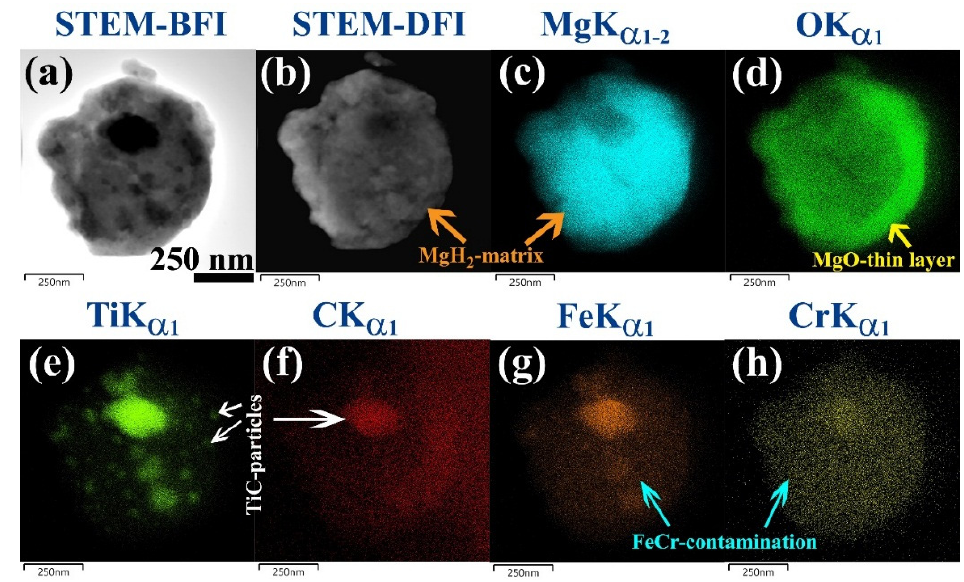
Figure 3. ( a ) STEM-BF; ( b ) STEM-DF micrographs and the corresponding X-ray elemental mapping of ( c ) Mg; ( d ) O; ( e ) Ti; ( f ) C; ( g ) Fe; and ( h ) Cr for aggregated MgH 2 /5.2TiC/4.6FeCr nanocomposite powders obtained after 50 h of ball milling.